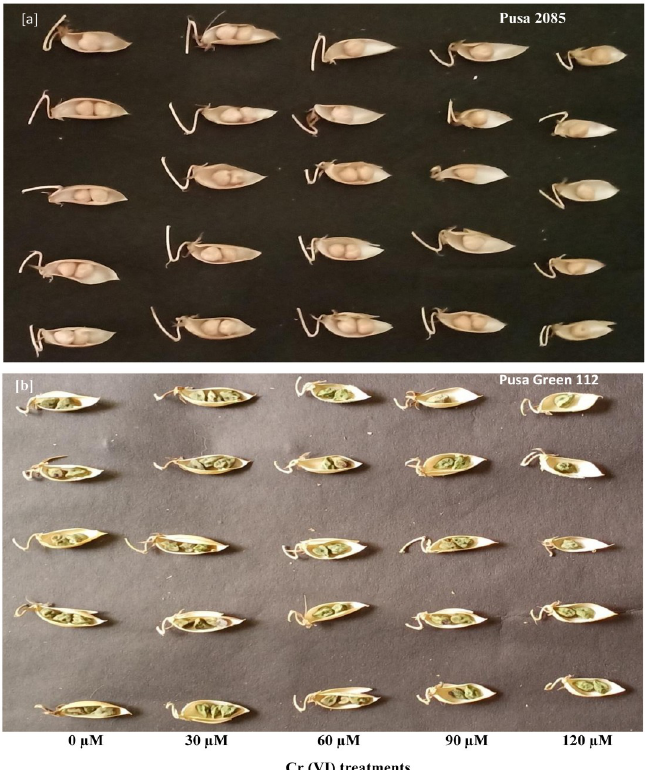
Fig 12. Effects of various chromium (Cr) concentrations on the seeds per pod in two chickpea varieties grown under potted conditions. (a) Pusa 2085. (b) Pusa Green 112.